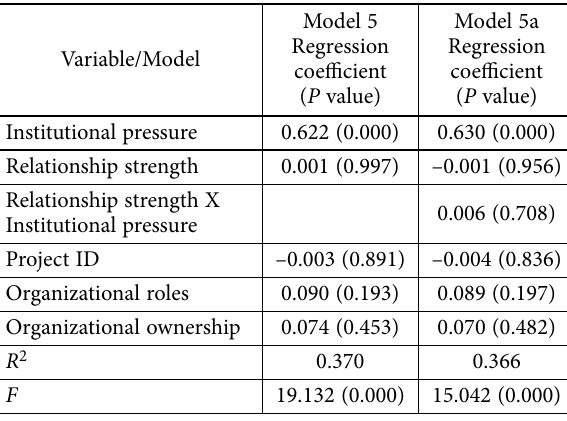
Table 9. Regression results for Model